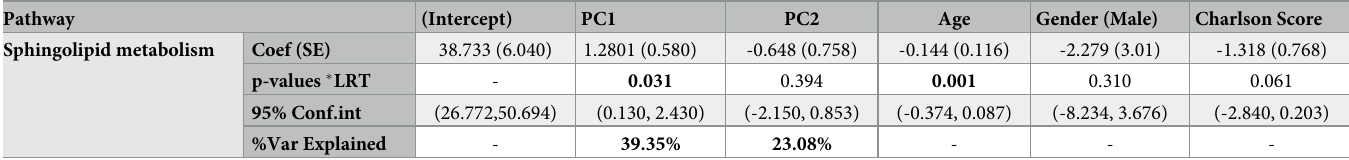
Summary of multivariate linear regression models with COVID-19 severity as the outcome using all patients, and the principal components used to summarize the enriched pathways associated with disease severity as the predictors. The models are also adjusted for the clinical covariates age, sex and Charlson comorbidity score. P- values for significance are determined via the likelihood ratio test (LRT).